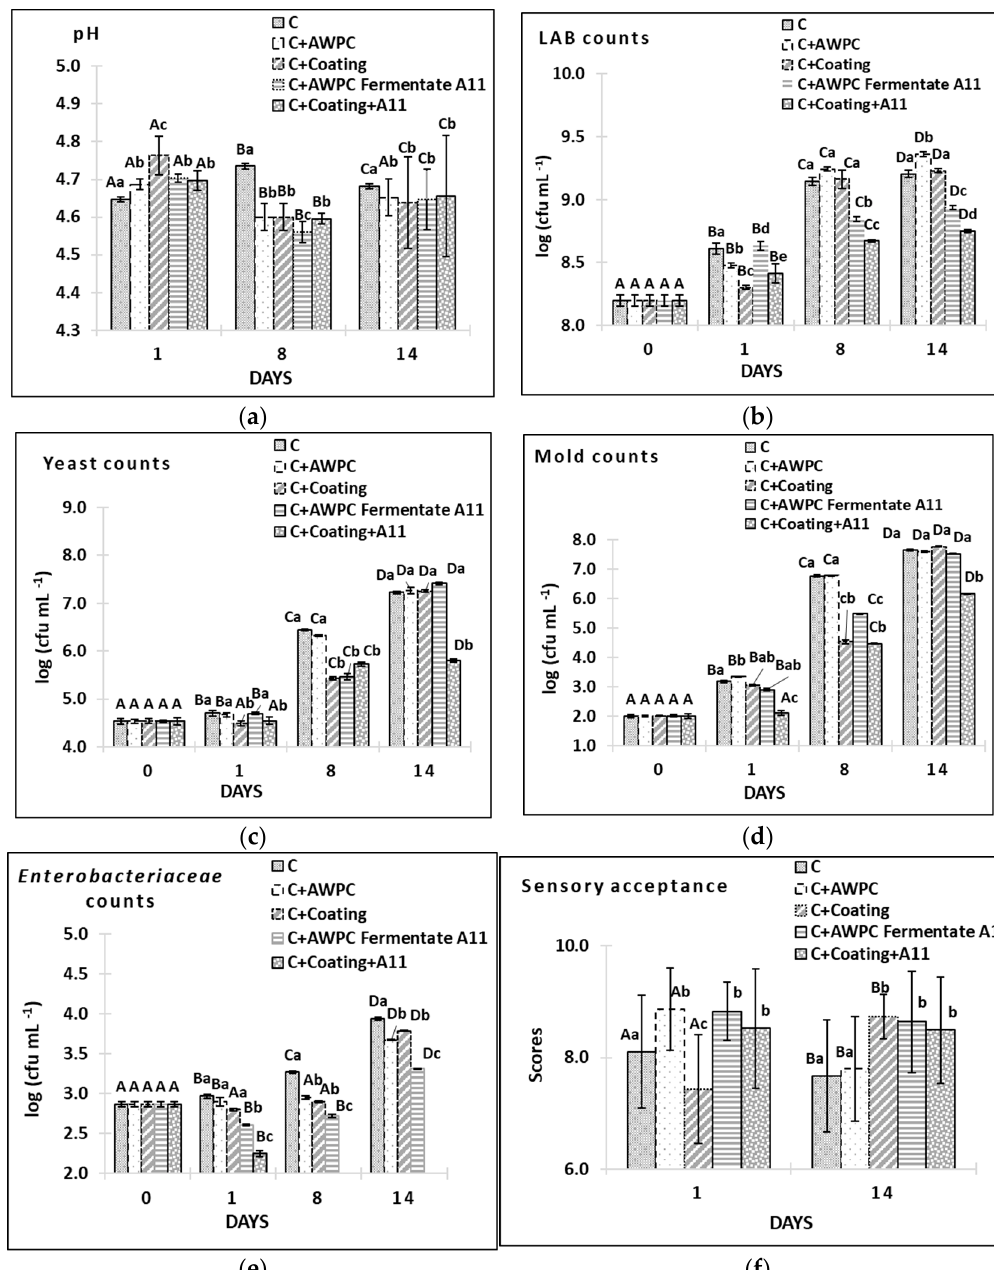
Figure 5. pH ( a ), LAB counts ( b ), yeast counts ( c ), mould counts ( d ), Enterobacteriaceae coun©( e ) and sensory acceptance ( f ) in control acid-curd cheese (C), acid-curd cheese coated with plain AWPC (C+AWPC), acid-curd cheese coated with plain coating (C+Coating), acid-curd cheese coated with AWPC L. paracasei A11 fermentate (C+AWPC Fermentate A11) and acid-curd cheese coated with coating with L. paracasei A11 fermentate (C+Coating+A11) during 14 days of storage at 4–6 °C.